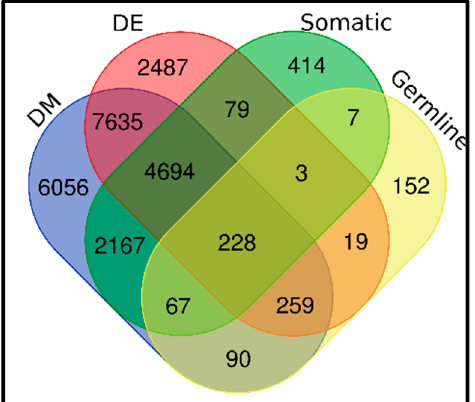
Figure 4. Four-way Venn diagram showing the distribution and the numbers of genomically, germline, somatically and epigenomically altered genes. DM indicates DNA methylation, DE denotes differentially expressed, and Somatic indicates somatic mutated